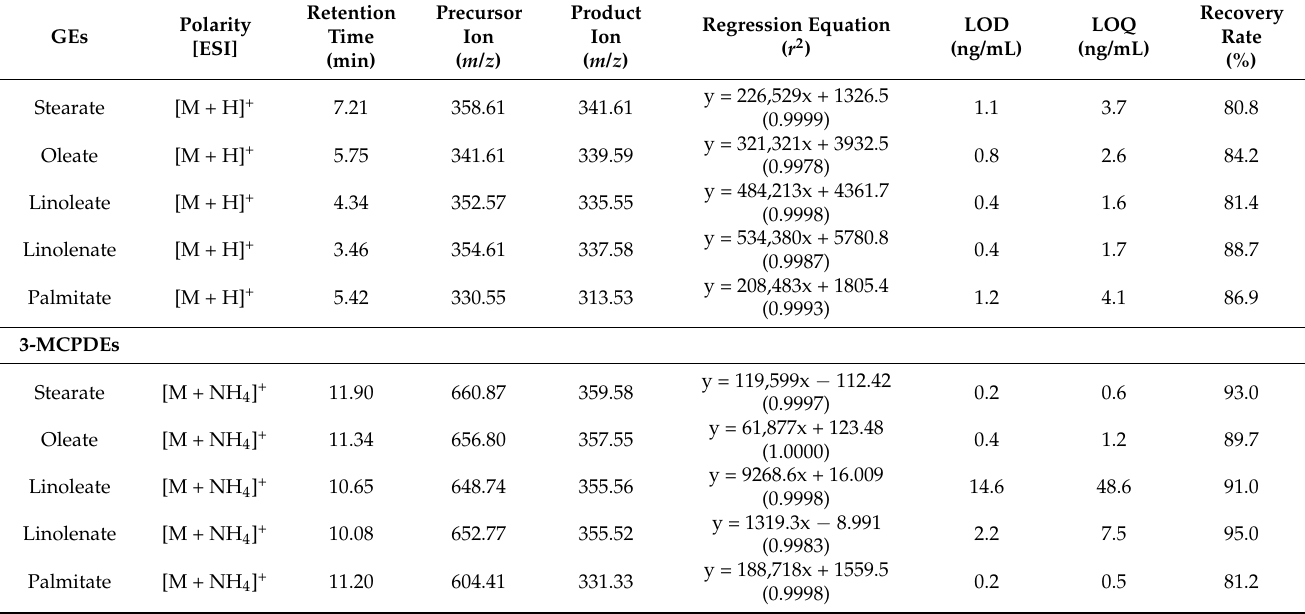
Table 2. LC-MS/MS acquisition parameters in multiple reaction monitoring (MRM) mode for GEs and